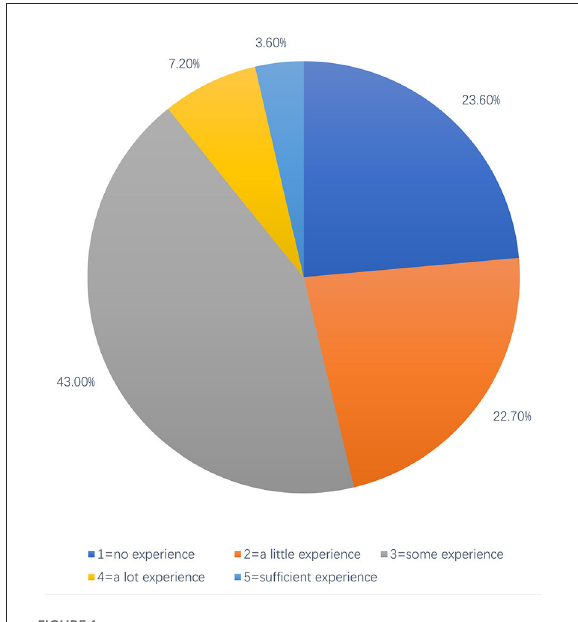
FIGURE1 Undergraduate medical students self-reported degree of clinical experience.